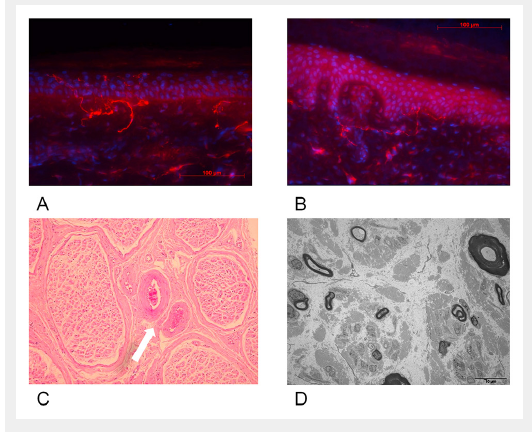
Distal lower limb skin and sural nerve biopsy in normal subject compared with patient 4. A: Distal lower limb biopsy of a normal subject (FO). Magnification 40x. Average intraepidermal nerve fibre density (IENFDd) = 12.7 s/mm. B: Distal lower limb skin biopsy of patient 4. Note rarefaction of intraepidernal nerve fibres. Magnification 40x. Average IENFd = 2.8 s/mm. C: Sural nerve biopsy of patient 4. Optical microspcopy (haematoxylin and eosin staining, orginal magnification 40x). Note microthrombosis of vasa vasorum (white arrow). D: Sural nerve biopsy of patient 4, electron microscopy. Severe loss of myelinated and unmyelinated